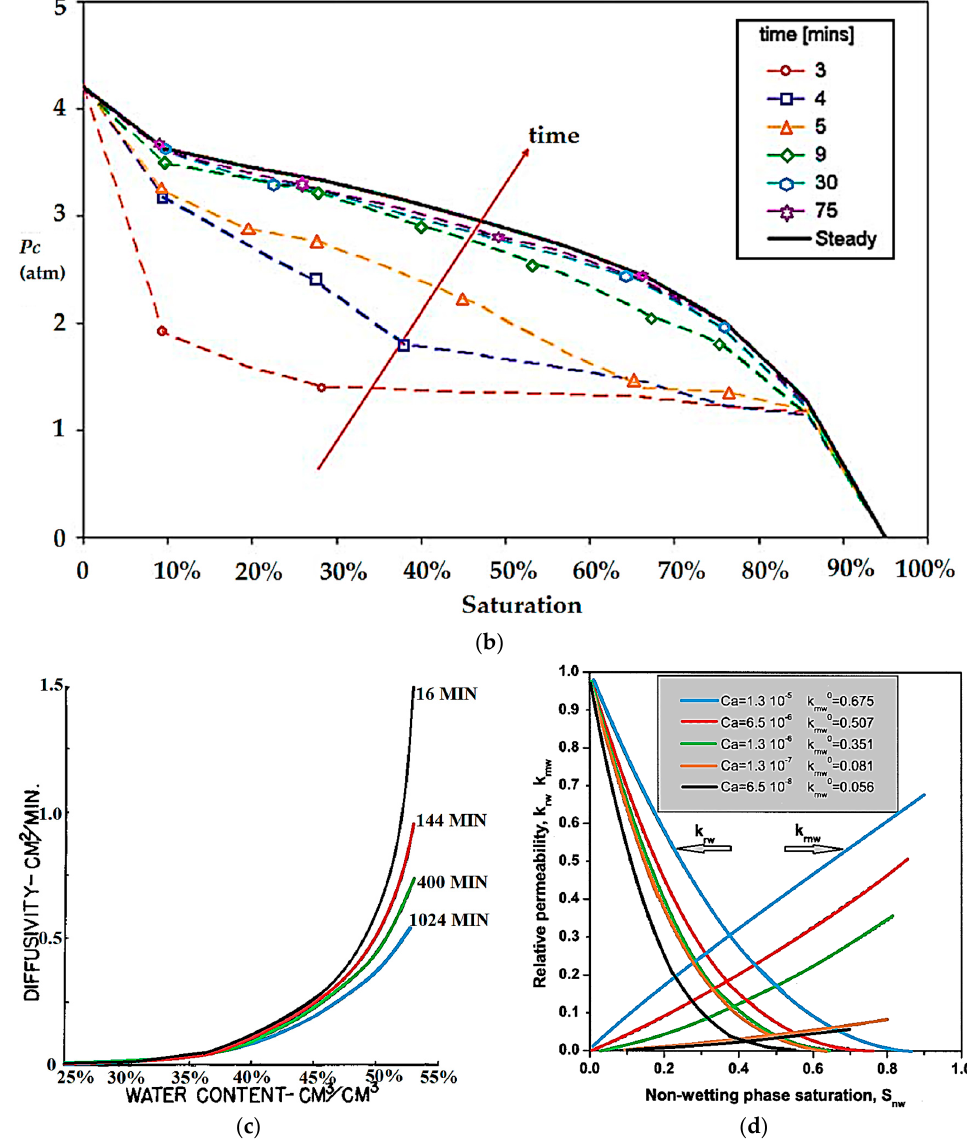
Figure 8. The manifestations of nonequilibrium transient two-phase flow: ( a ) the dynamic effects in drainage SWRC [21]; ( b ) the dynamic effects in imbibition SWRC [29]; ( c ) the speed-dependent dif- fusivity against water content [123]; ( d ) the dynamic effects in relative permeability [124]. The dynamic nonequilibrium effects in drainage SWRC founded by Topp, Klute and Peters [21] were also experimentally measured from later studies [37,125–129]. These works used a similar setup, although, except Wana-Etyem [128], most of them solely fo- cused on the drainage curve. Stauffer [37], Weller , et al. [130], and Weller and Vogel [131] also checked the relative permeability or HCF and found that it also had dynamic nonequilibrium effects. Smiles, Vachaud and Vauclin [126] confirmed that dynamic drain- age curves have higher suction than static drainage curves, but they concluded that the imbibition curve had no observable dynamic effects. Nevertheless, this was later chal- lenged by Wana-Etyem [128] that dynamic effects happen for both drainage and imbibi- tion SWRC, as shown in Figure 8a,b. The nonequilibrium soil water retention behaviour